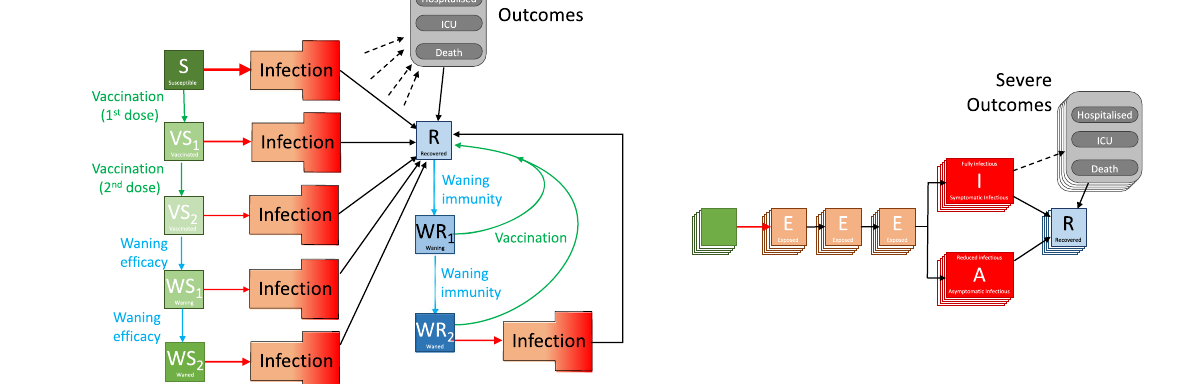
and whether the infectious class is associated with symptomatic or asymptomatic infection. Each compartment is shown as multi-layered to indicate additional age-, regional- and variant-speci fi c heterogeneity. Severe outcomes of hospital or ICU admission and death (shown with dashed arrows) are related to the level of infec- tion in each age-group and their degree of vaccine (or infection-induced)